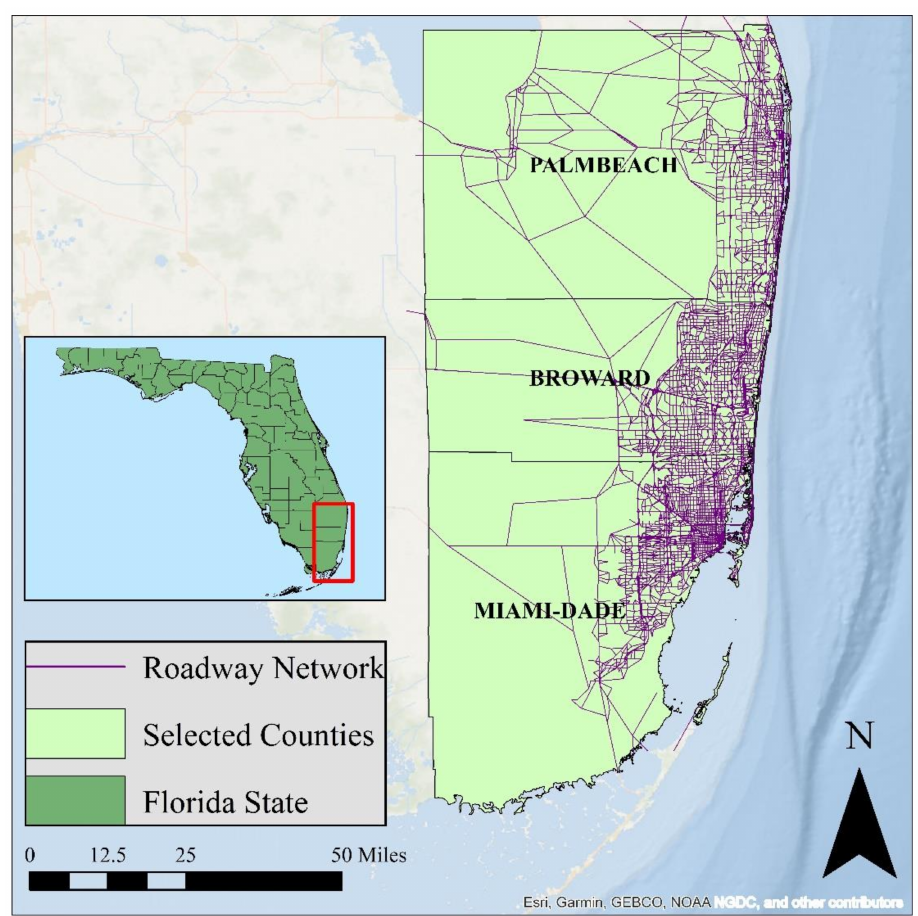
Figure 2. Study area.